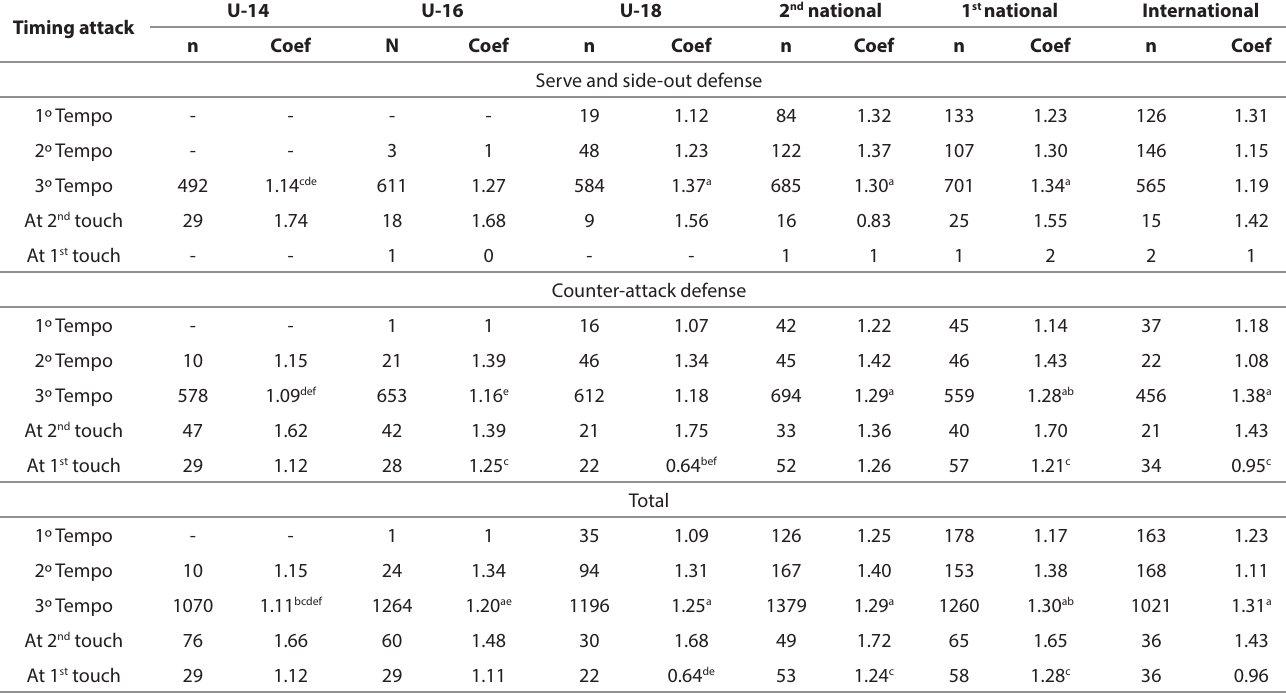
TABLE 3. Efficiency of blocking according to game phase, timing of the attack and levels of competition (women’s volleyball) Timing